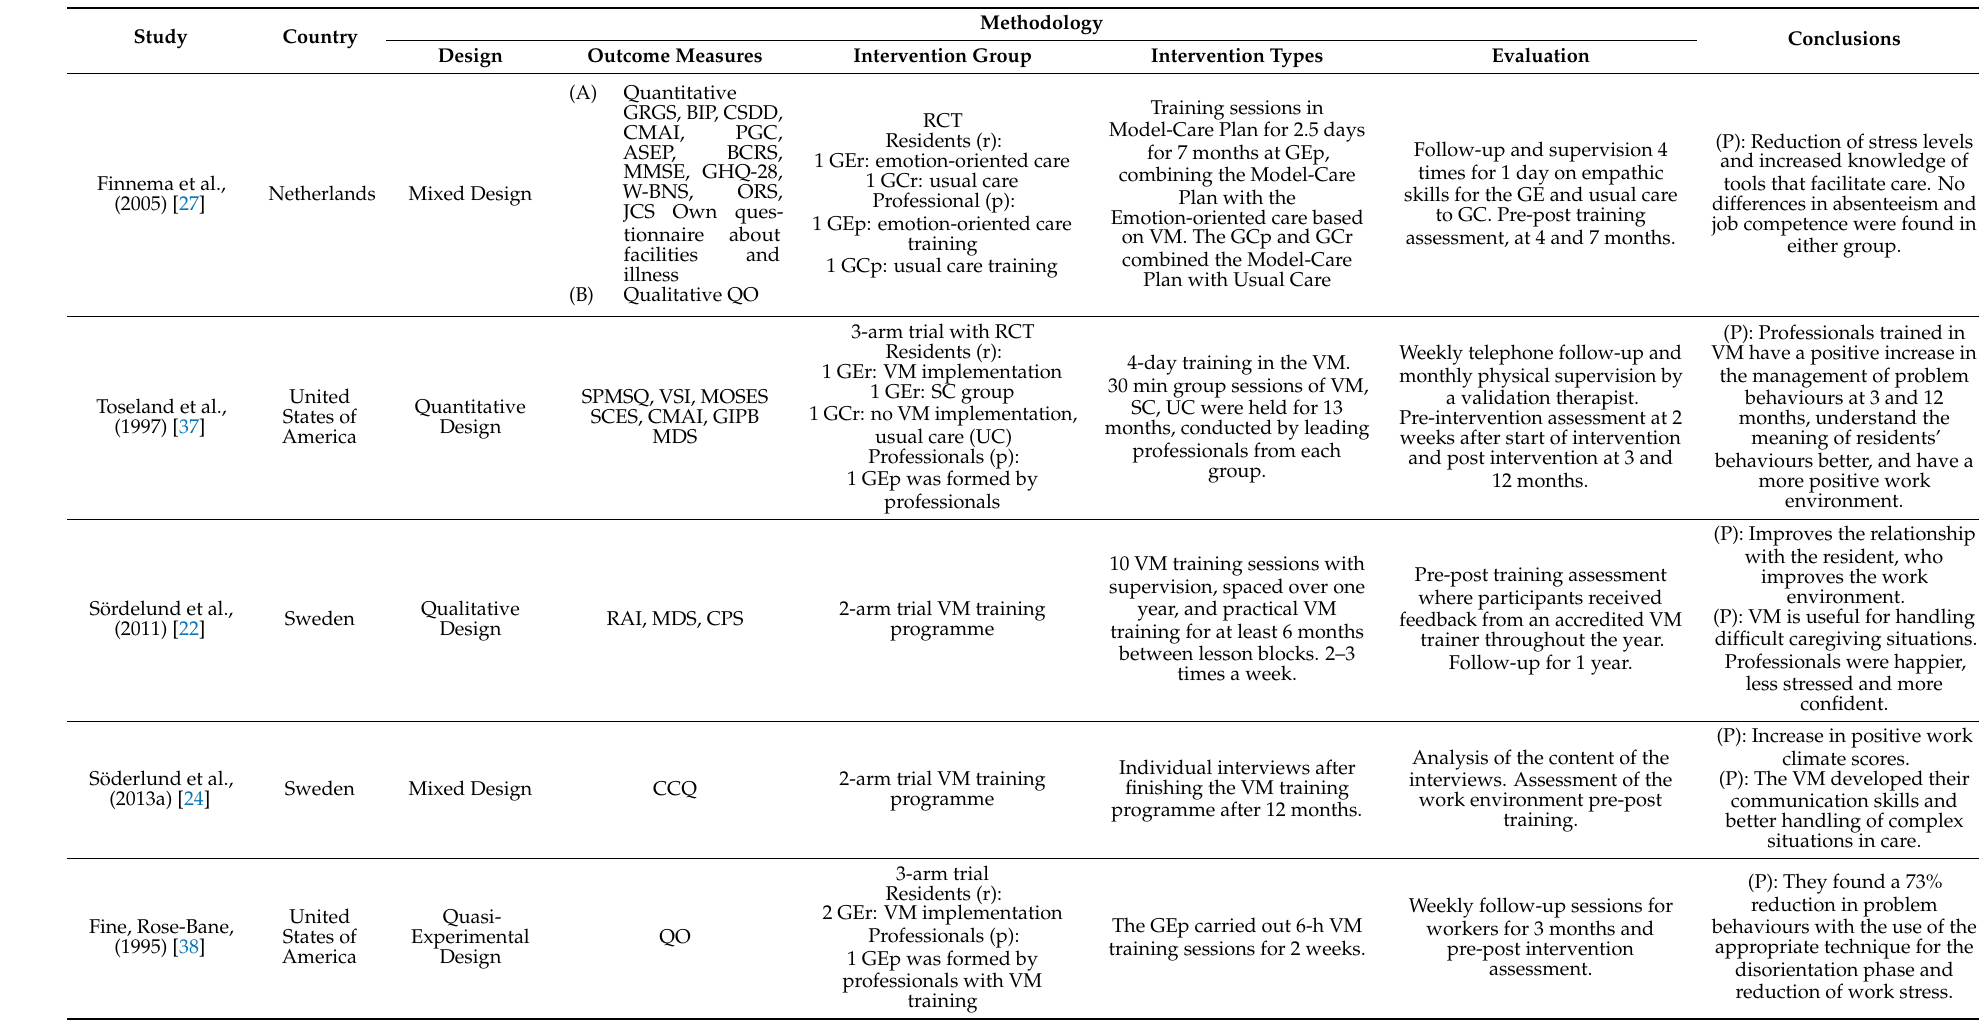
Table 4. Included studies on the effect of VM training on healthcare